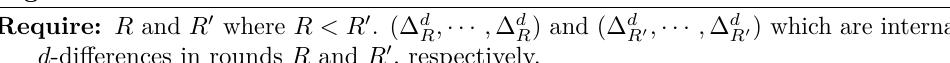
Algorithm 1 Find.Middle. d